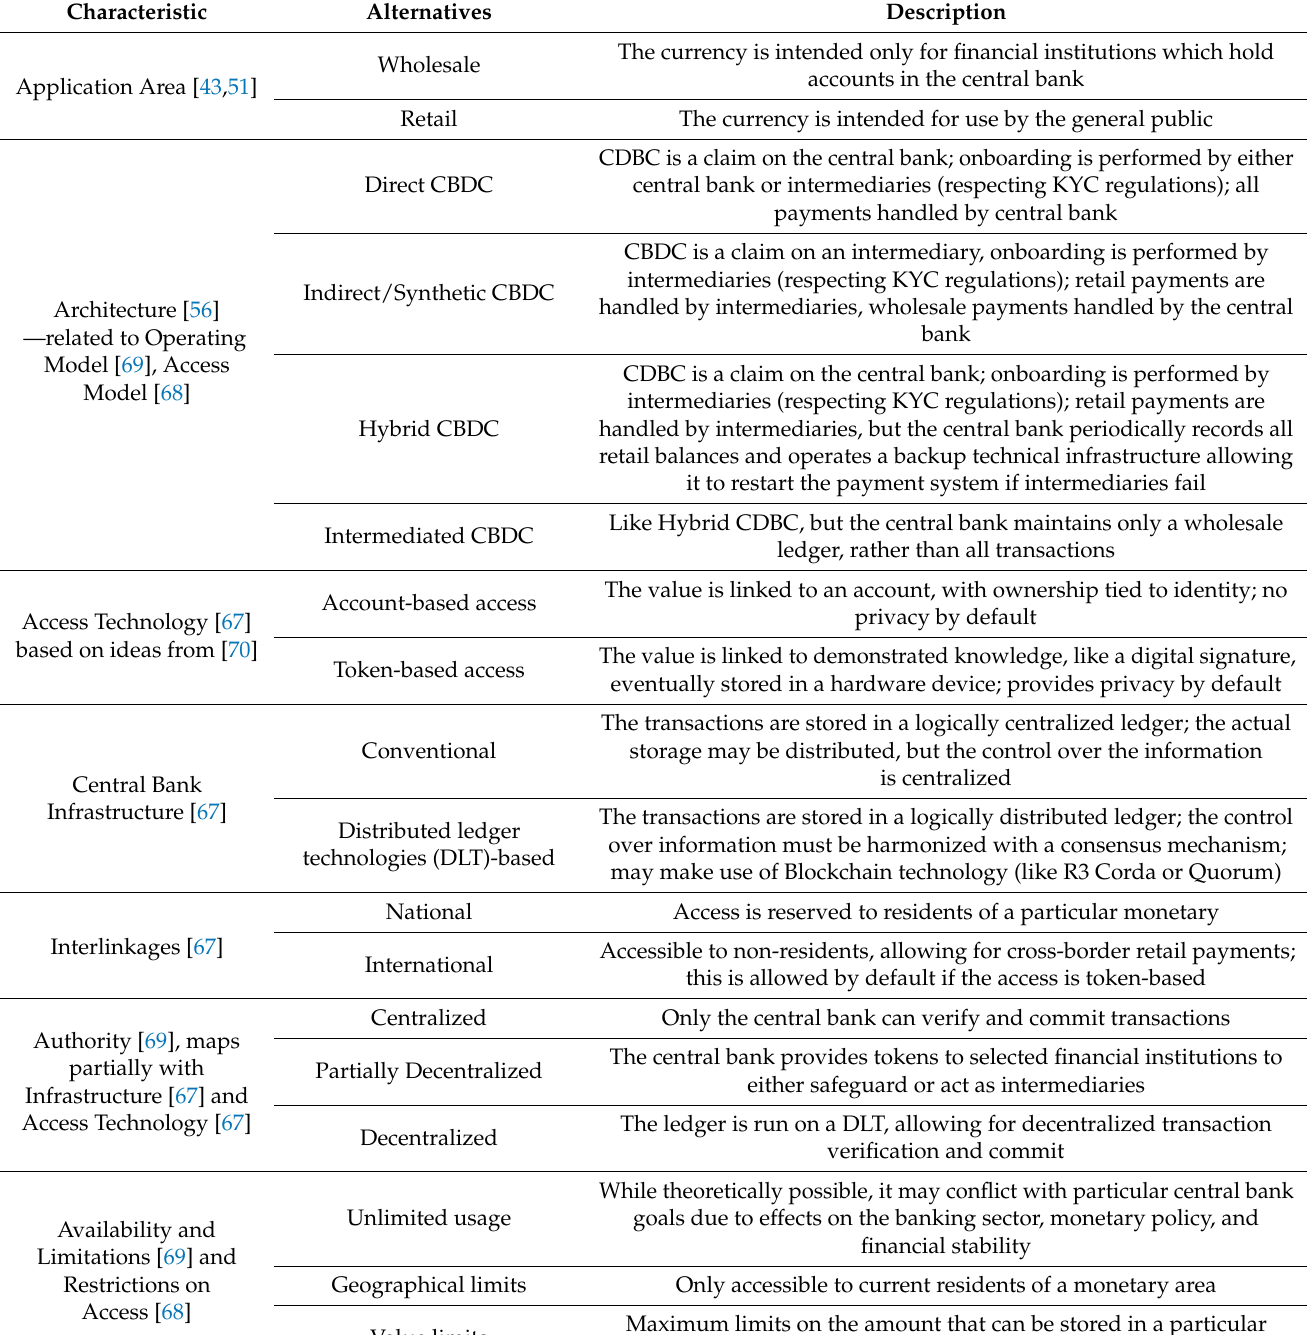
Table 2. CDBC main characteristics/design goals; Source: authors’